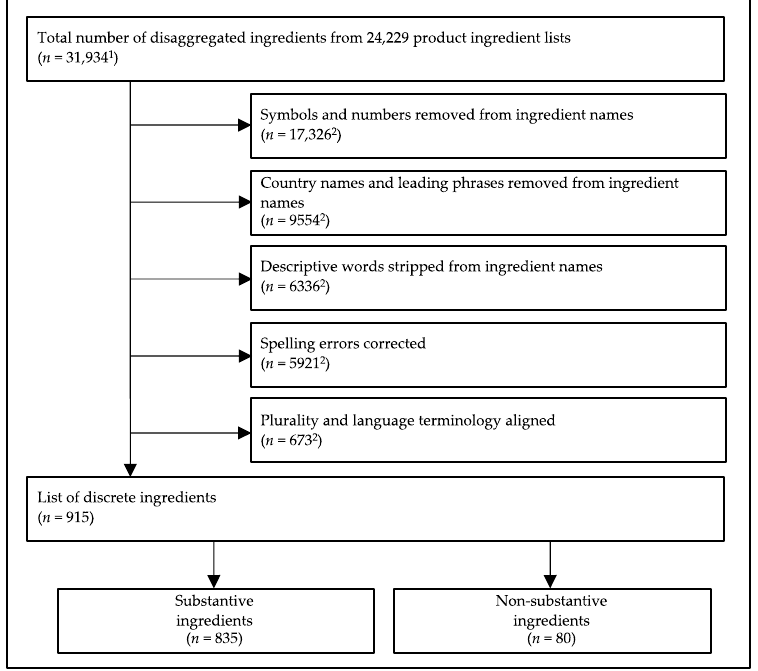
Figure A3. Flowchart describing ingredient cleaning and classifications. 1 The original 31,934 ingredi- ents were a result of the original ingredient disaggregation and consolidation into unique ingredient names. 2 A number of ingredients required multiple cleaning steps, so the number of ingredients cleaned in each step sums to more than the total number of disaggregated ingredients